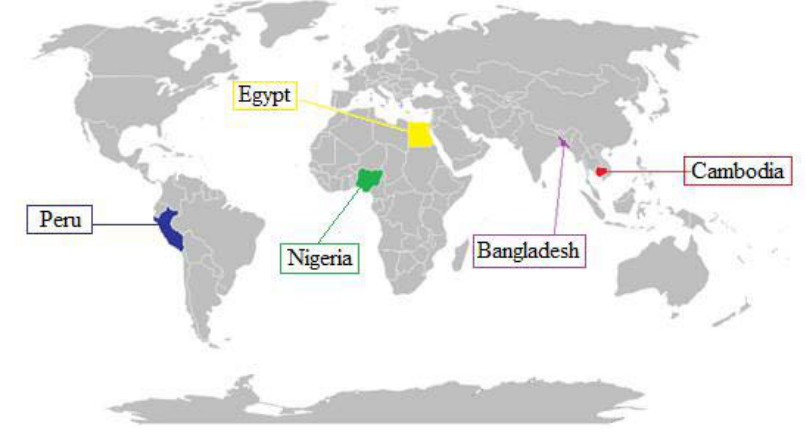
Figure 2 Exemplar countries used in the